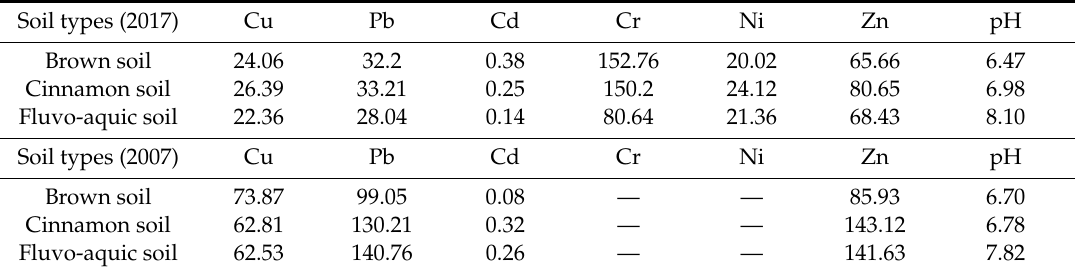
Table 2. The concentrations of heavy metals in 2007 and 2017 (mg · kg − 1 ) [5].